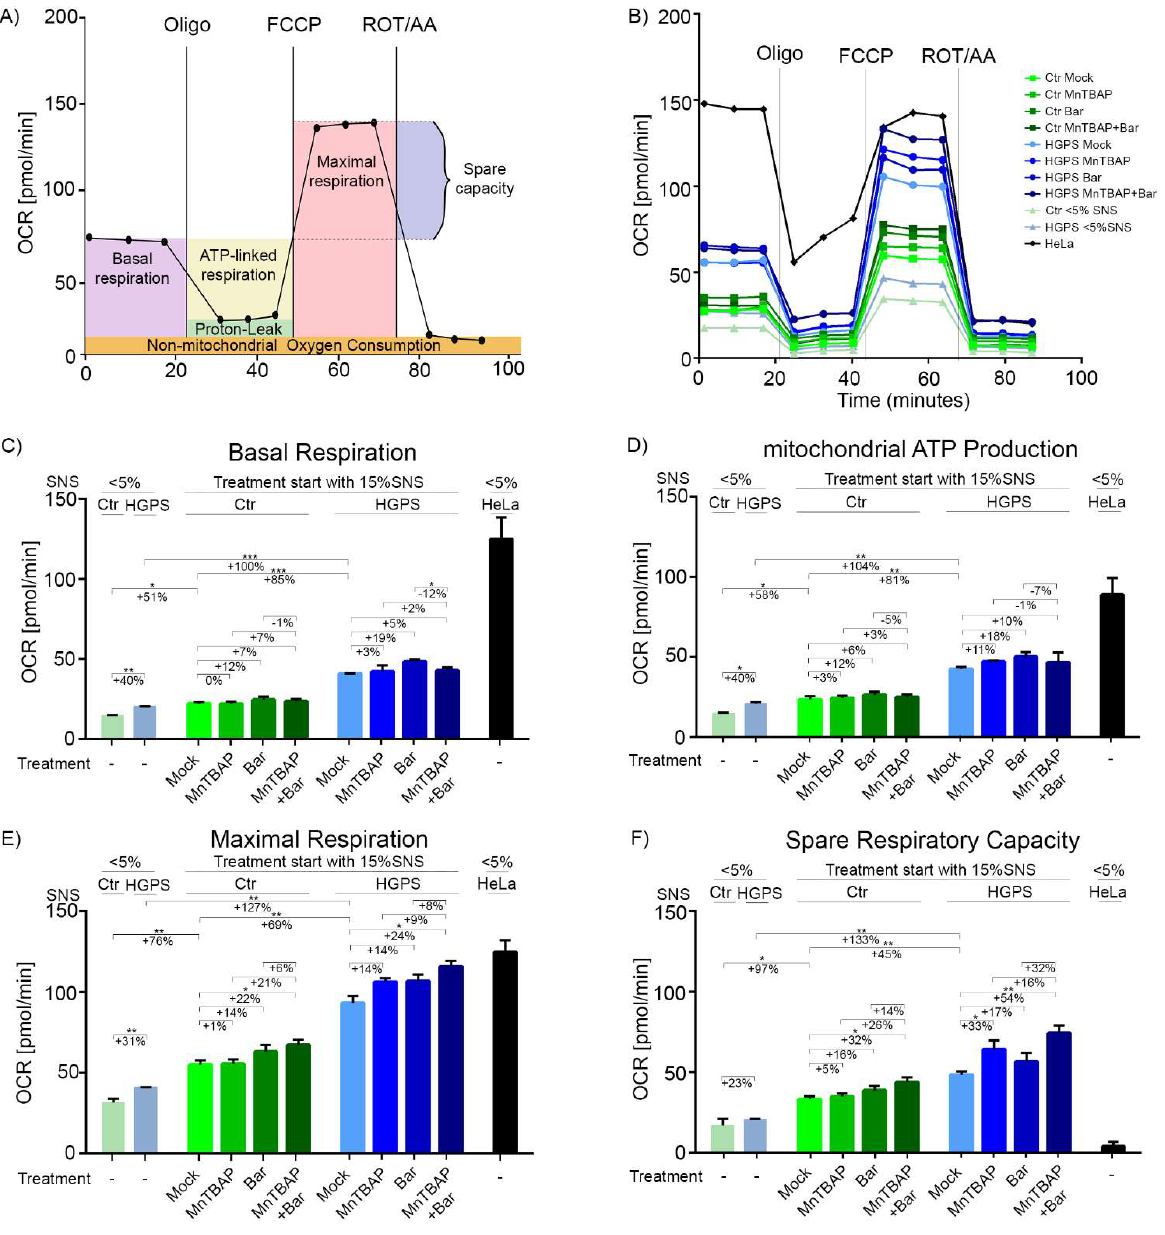
Figure 4. Mitochondrial function is altered in HGPS fibroblasts. ( A ) Schematic overview of the cell mito-stress test profile created using Inkscape. ( B – F ) Oxygen-consumption rates (OCR),